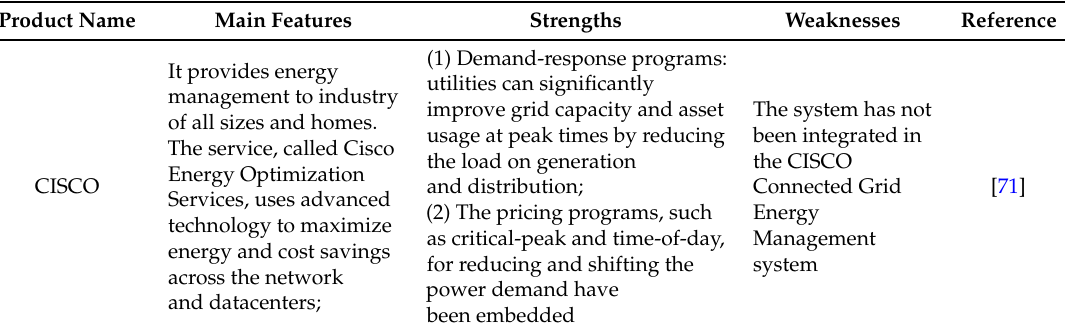
Table 4. Comparison of the analyzed